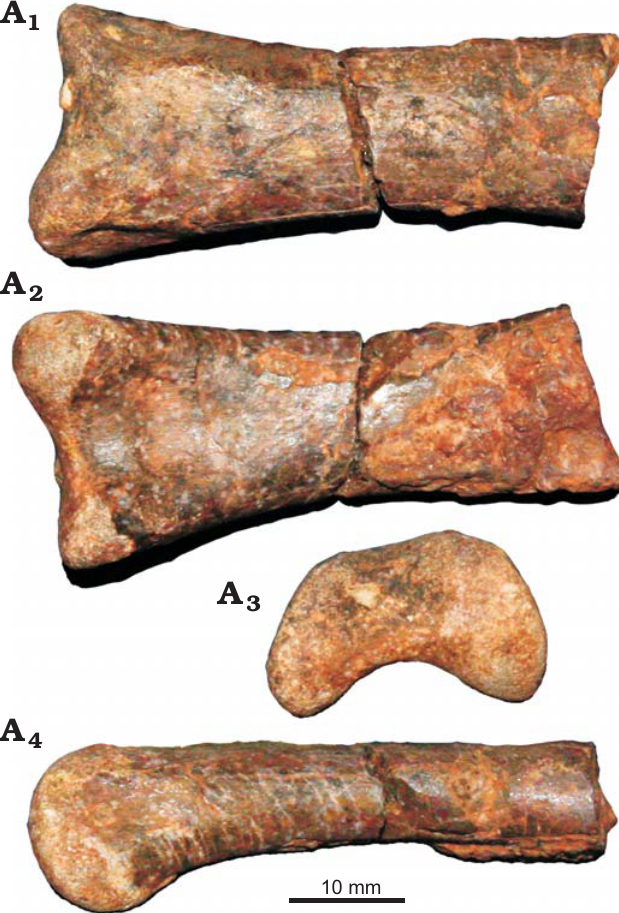
Fig. 5. Coelurosaurian theropod Phuwiangvenator yaemniyomi gen. et sp. nov. from the Early Creta ceous Sao Khua Formation of Phu Wiang, Khon Kaen Province, Thailand. SM-PW9B-6, right metacarpal II in dorsal (A 1 ), ventral (A 2 ), distal (A 3 ), and medial (A 4 )